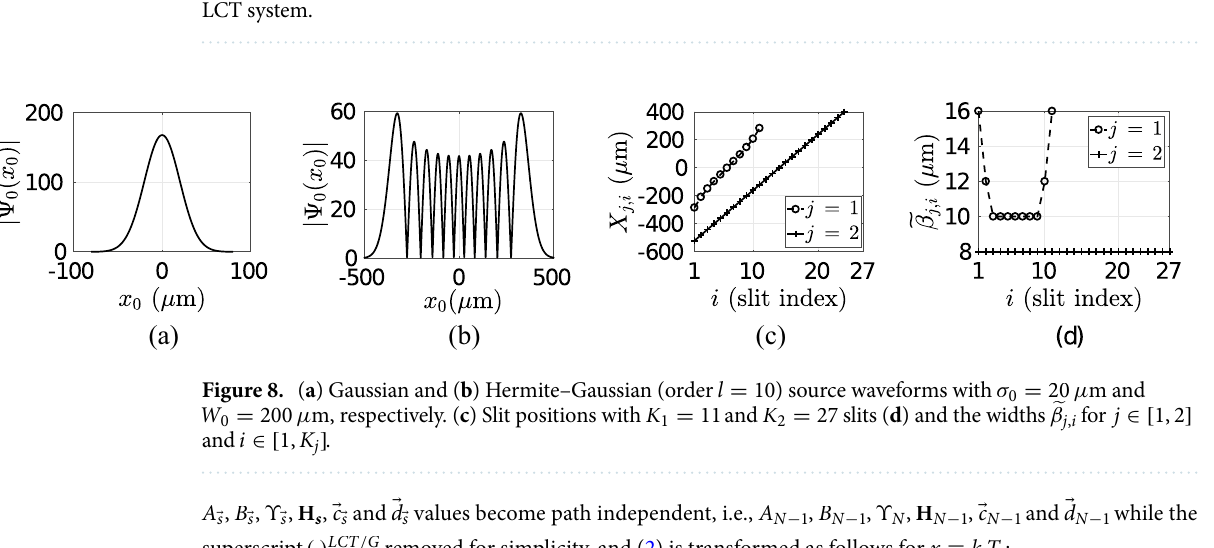
Figure 8. ( a ) Gaussian and ( b ) Hermite–Gaussian (order l 200 µ m, respectively. ( c ) Slit positions with K 1 W 0 = 1, K and i j ] ∈ [